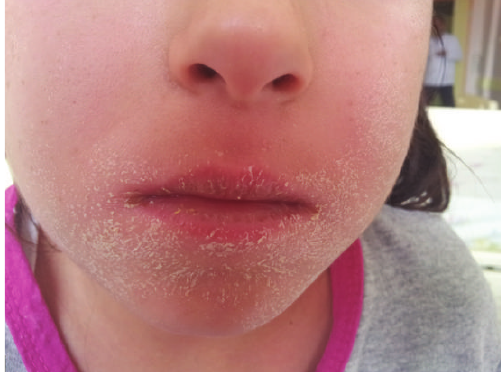
Figure 3: During the improvement process, desquamation on face.